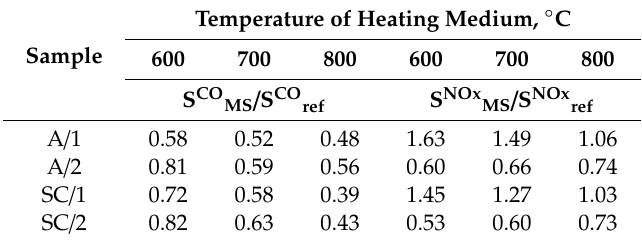
Table 3. Relative integrand area of peaks related to CO an NO x release for the initial (S CO ref and S NOx ref ) and modified (S CO MS and S NOx MS )